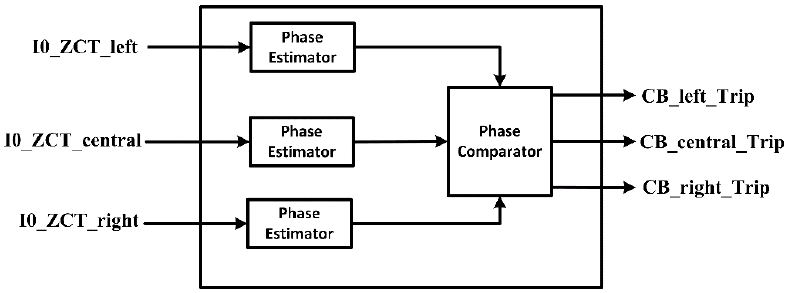
Figure 12. Block diagram of the proposed unit protection.